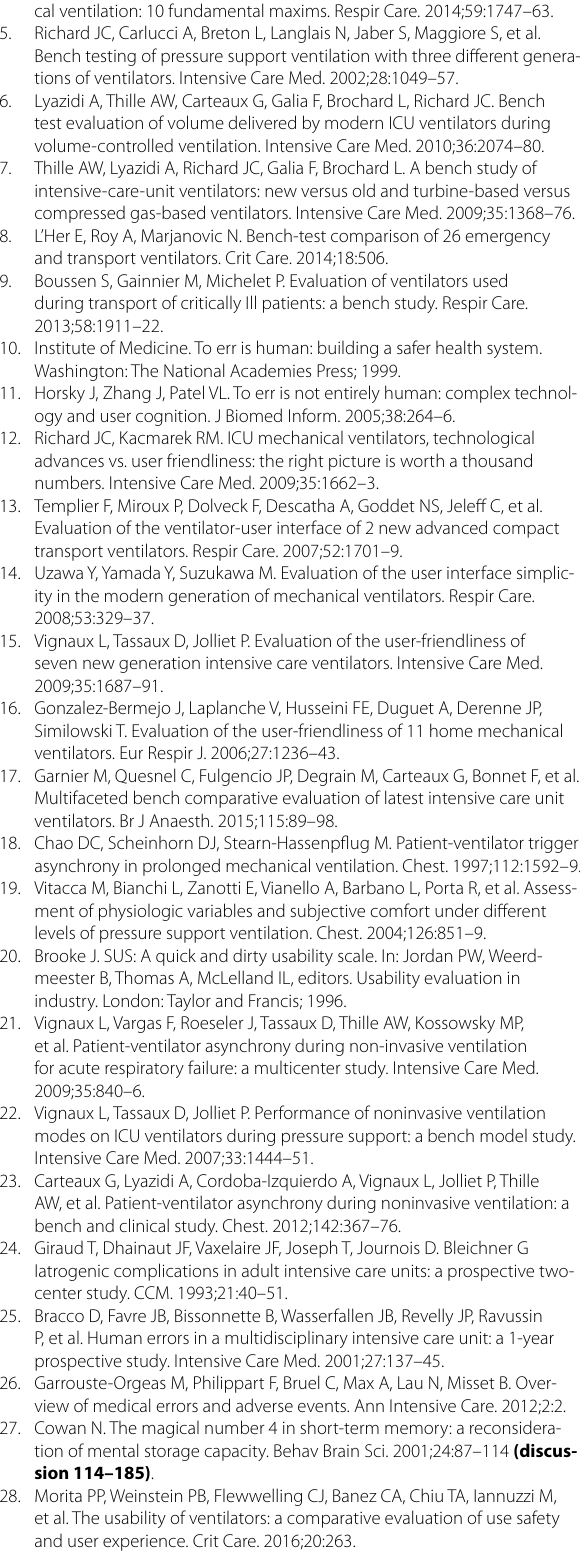
list and cumulated knowledge. Figure S1. Pupillar diameter variation measurements. Figure S2. Overall inspiratory triggering delay. Figure S3. Asynchrony types for each device in the noninvasive ventilation